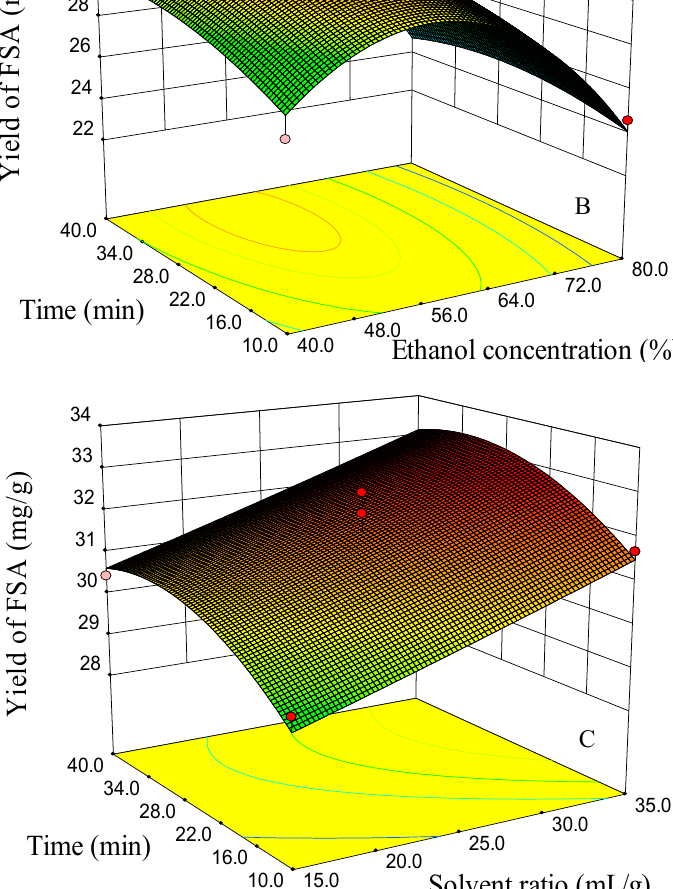
Figure 8. Response surface and contour plots for the effect of ( A ) EtOH concentration/solvent ratio, ( B ) EtOH concentration/time and ( C ) time/solvent ratio on the yields of forsythiaside A (FSA).